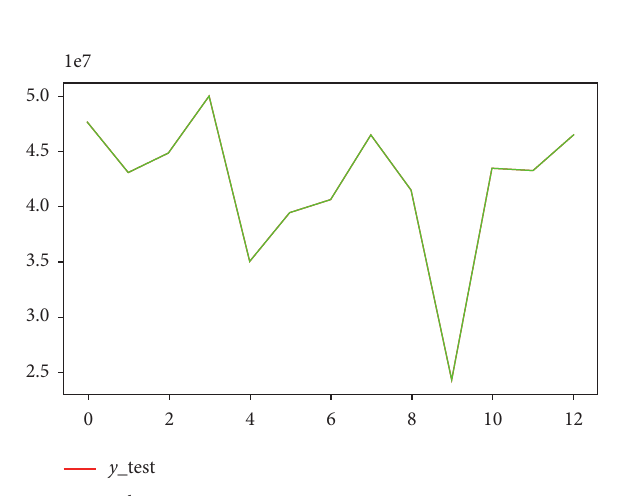
Figure 8: Comparison of predicted and real